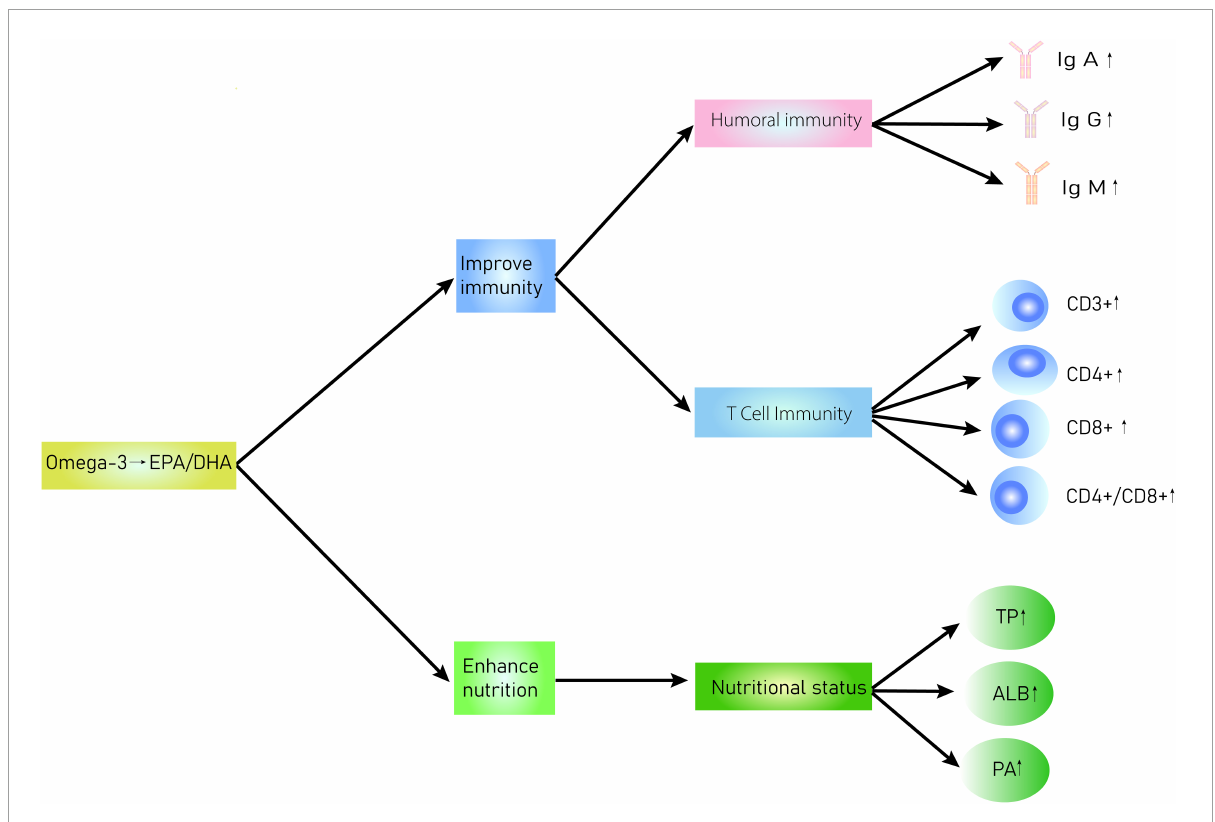
FIGURE10 Interaction diagram of omega-3 PUFAs regulation of immune functions and nutritional status in patients with CRC.